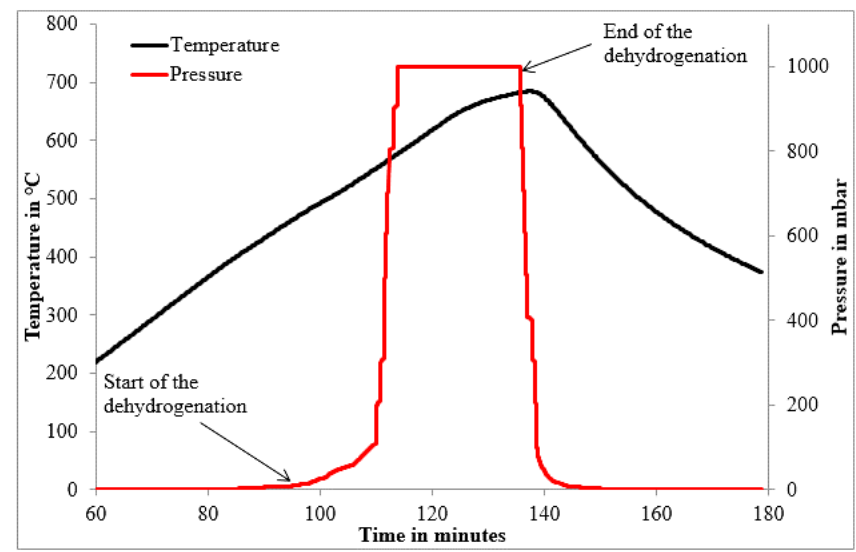
Figure 3. Temperature measurement time during dehydrogenation of the hydrate powders.